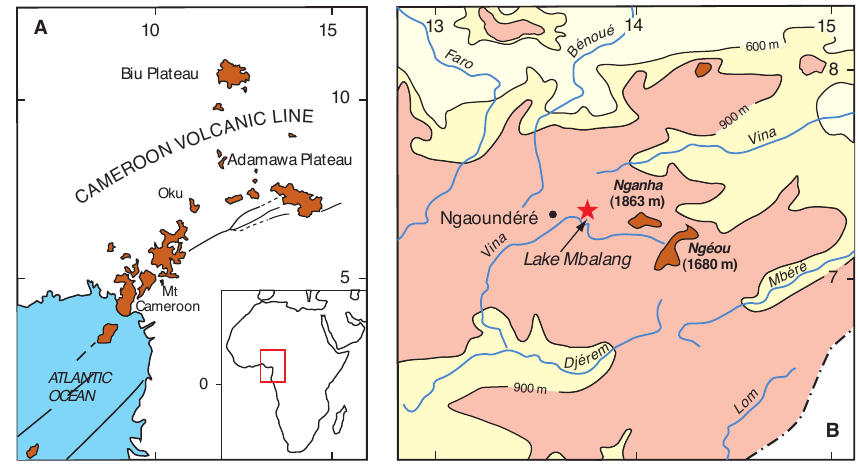
Fig. 1. (A) : The Cameroon volcanic line; (B) : Location of Lake Mbalang on the Adamawa plateau, Central Fig. 1: A: The Cameroon volcanic line; B: Location of Lake Mbalang on the Adamawa plateau, central Cameroon.